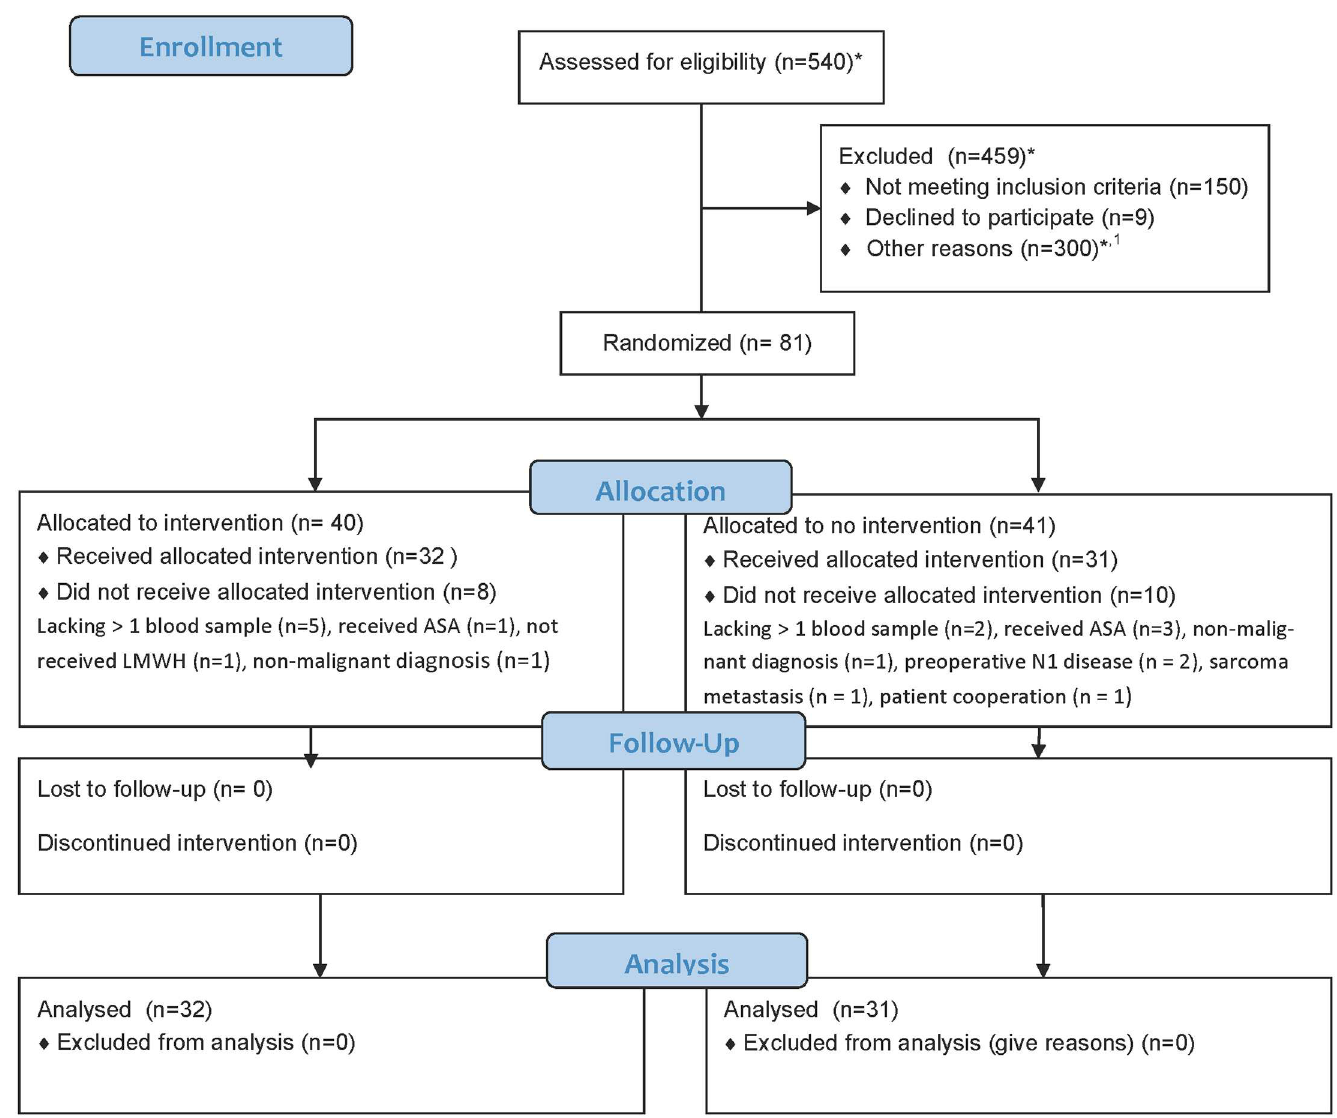
Fig 1. Trial flowchart for patients planned for Video-Assisted Thoracoscopic Surgery (VATS) lobectomy for primary lung cancer. * : Estimated with some uncertainty. 1 : This includes: 1) Patients operated on Thursday and Fridays; 2) No specialized laboratory technicians available; 3) Not practical possible to get permission from the patient to participate; 4) Other logistic problems. Abbreviations: n/N: numbers; ASA: Acetylsalicylic acid (aspirin); LMWH: Low-Molecular-Weight Heparin; NSAID: Non-SteroidAnti Inflammatory Drug.